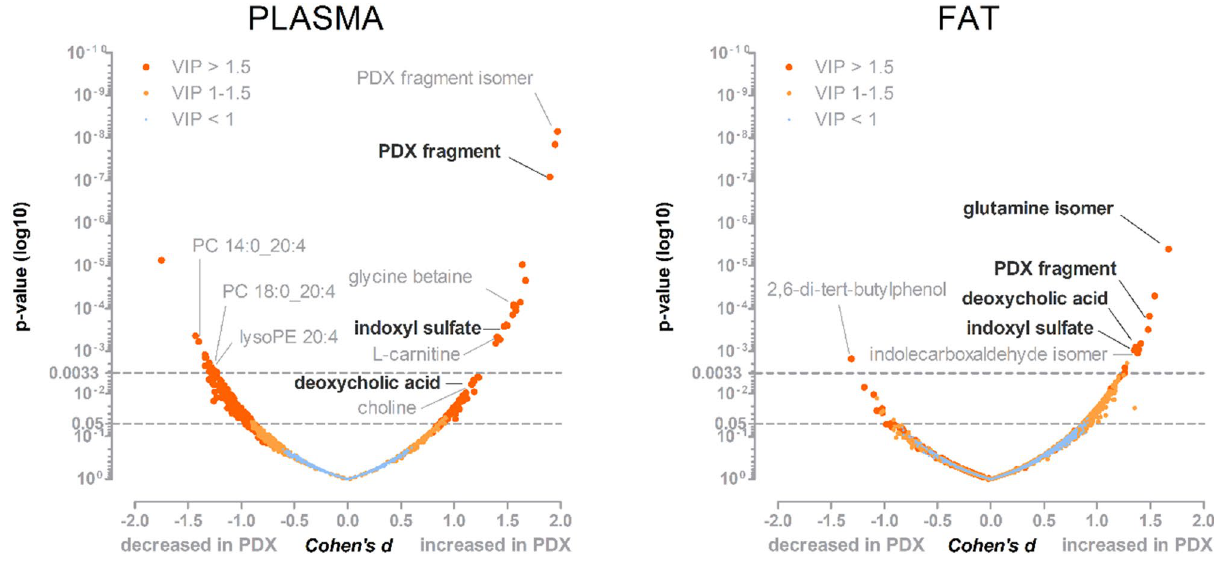
Figure 1. Overview of the metabolomics analysis of plasma and epididymal adipose tissue samples. Volcano plots showing the measured molecular features from plasma and fat tissue samples, which are indicated by the dots. p Values were calculated using Welch’s t-test, and 0.0033 was set as the adjusted α level (Bonferroni’s method). Cohen’s d values were calculated between PDX-treated and control animals, where a positive d-value indicated that the metabolite was identified at higher levels in PDX-fed animals and a negative d-value indicated higher levels in control animals. Variable importance to projection (VIP) values from the partial least